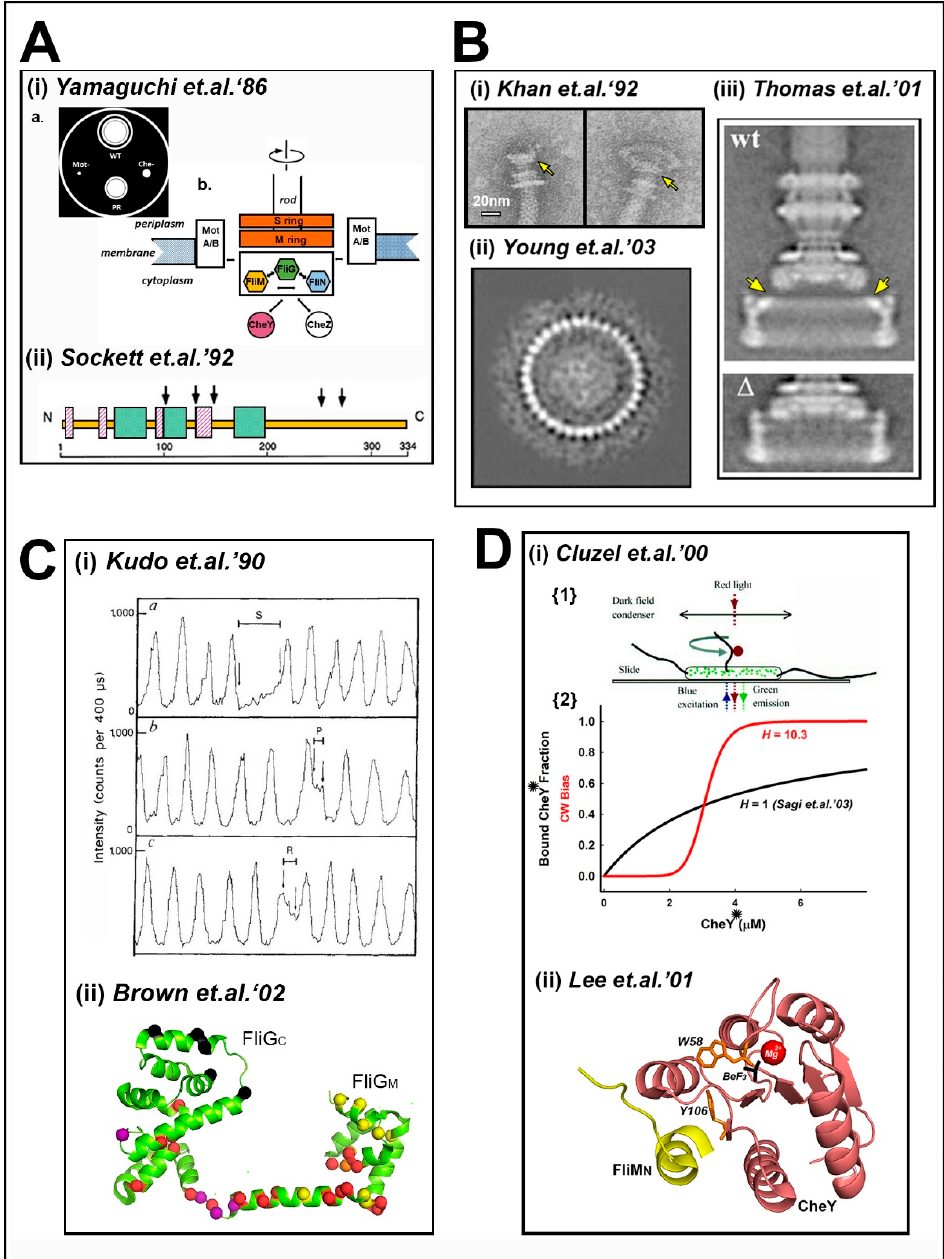
Figure 1. The bacterial flagellar motor (BFM) switch—landmarks. ( A ) Conceptualization: ( i ) The switch complex was proposed based on phenotypic characterization of mot , che and fla alleles and